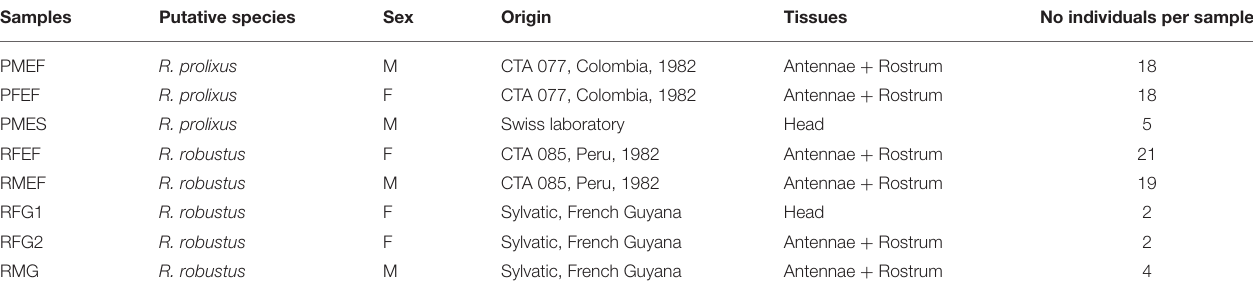
TABLE 1 | Rhodnius samples.